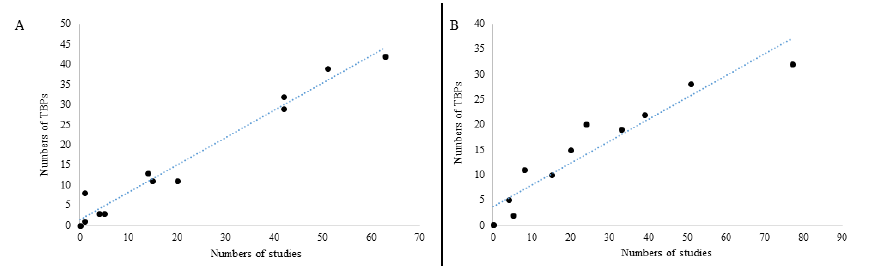
Figure 5. ScatterPlot diagrams showing a strong linear correlation between ( A ) the number of studies and the number of TBPs from positive ticks by domestic animal (correlation coefficient R = 0.98), and ( B ) between the number of studies and the number of TBPs by positive domestic animal (correlation coefficient R = 0.95).